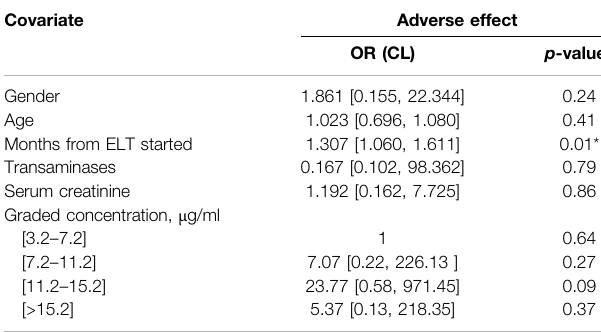
TABLE 4 | Multivariate logistic regression analysis of variables associated with adverse drug reaction.